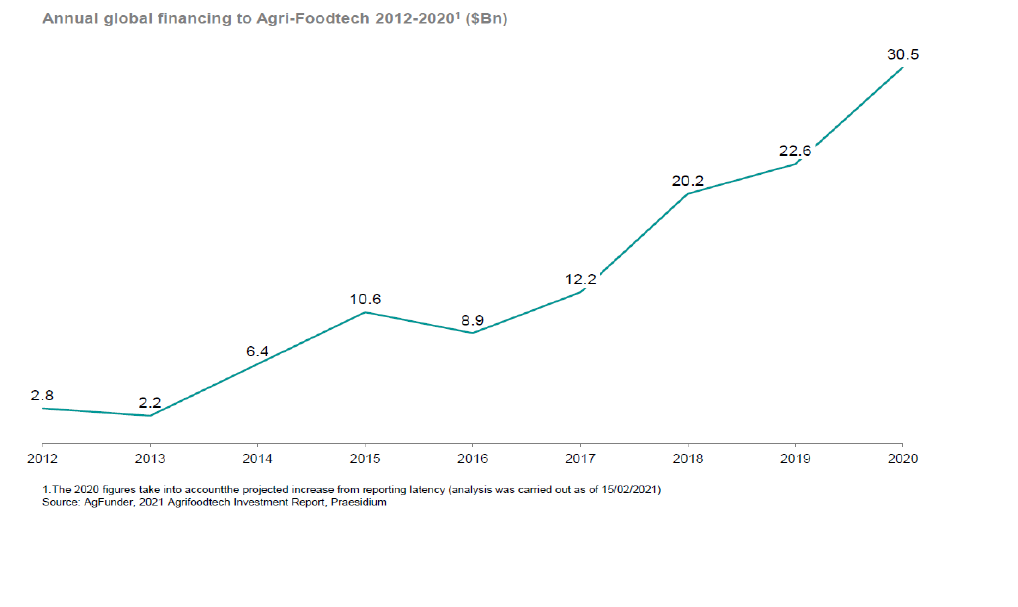
Figure 3: Agri-foodtech Investment